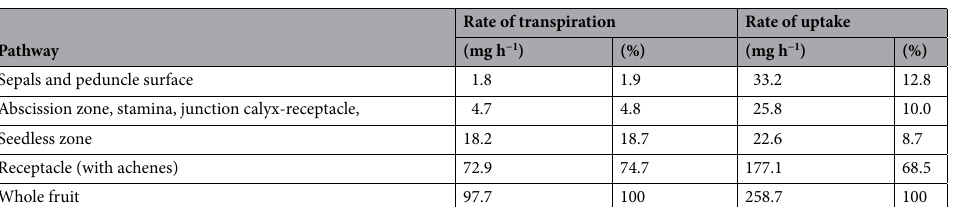
Whole Table 3. Relative contribution of different pathways to whole fruit transpiration and water uptake into strawberry fruit cv. Sonsation. The pathways were: sepals, the peduncle surface, abscission zone of petals, stamina, the junction between calyx and receptacle, and the seedless zone of the receptacle. Data is calculated from data in Table 2.